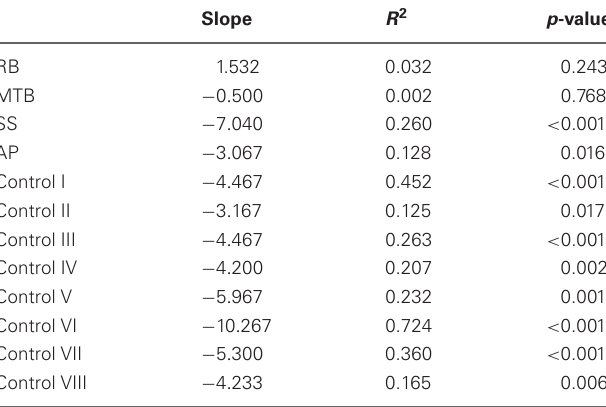
Table 2B | Regression values for Immediate Open-loop grasping.